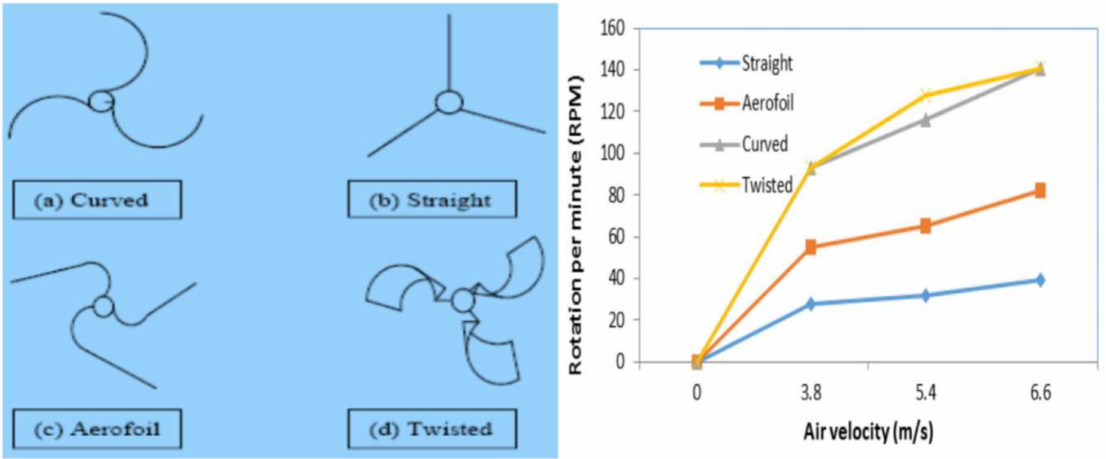
Figure 9. Types of Savonius blades and their turbine rotational speed